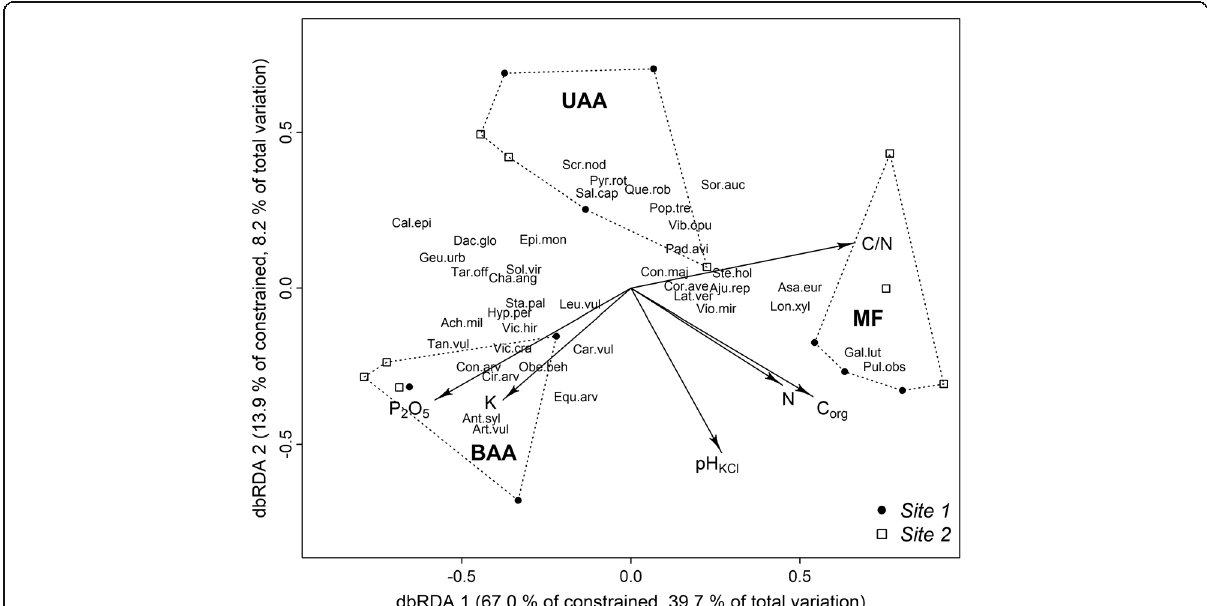
Fig. 11 db-RDA ordination triplot relating the plant species to the selected soil variables (full-line arrows). Letters represent positions of the significant ( P < 0.05) indicator species with IndVal > = 50%. The first three letters are for the generic name and the last three letters are for the specific epithet. The biotopes are indicated by convex hulls (dotted lines). UAA unburnt abandoned arable land, BAA burnt abandoned arable land, and MF mature